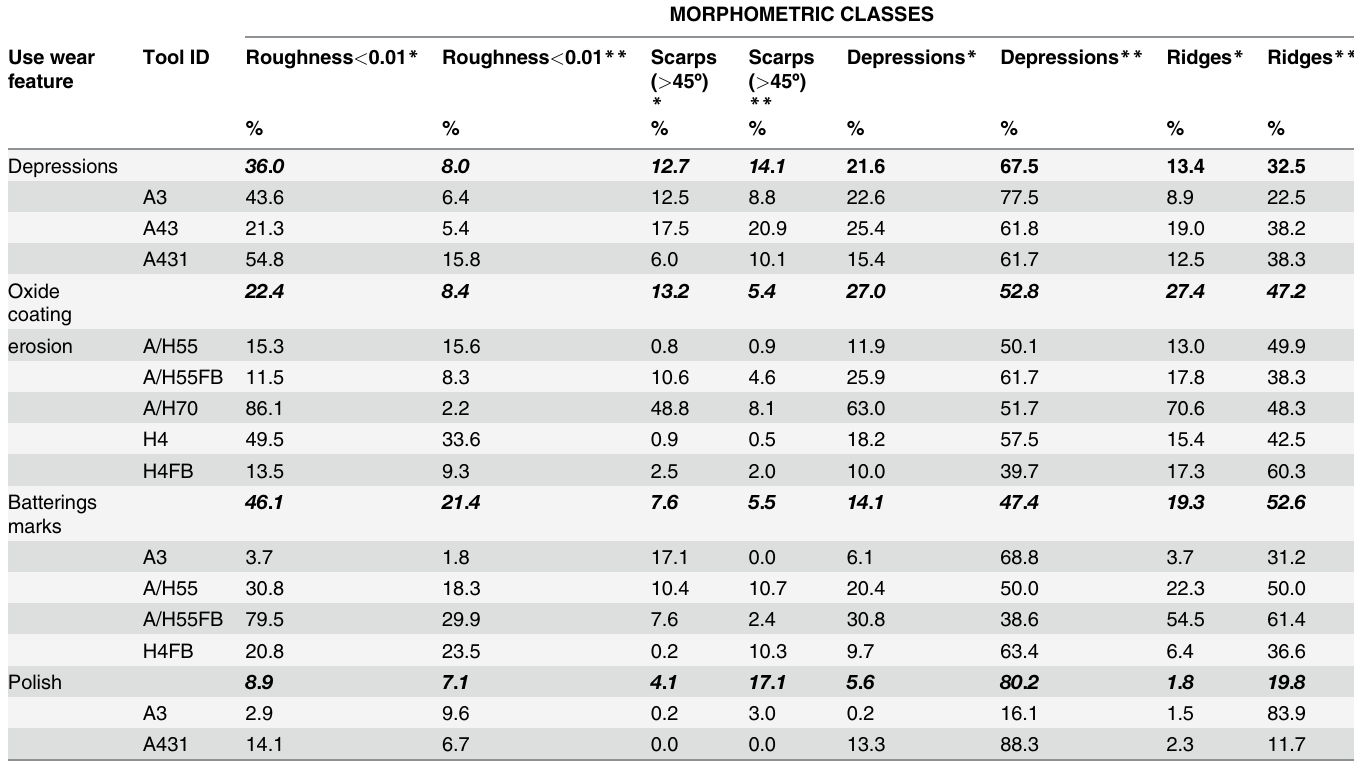
MORPHOMETRIC CLASSES